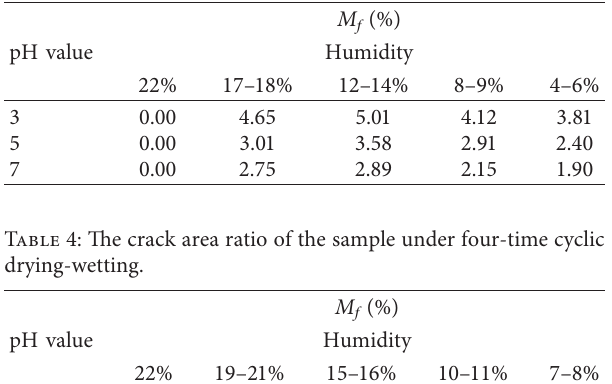
Figure 6: Crack development of sample with different humidity after four-time cyclic drying-wetting. (a) pH � 3, (b) pH � 5, and (c) pH � 7. Table 3: The crack area ratio ( M Table 5: The average crack width of the sample after one-time f ) of the sample after one-time cyclic drying-wetting. cyclic drying-wetting.